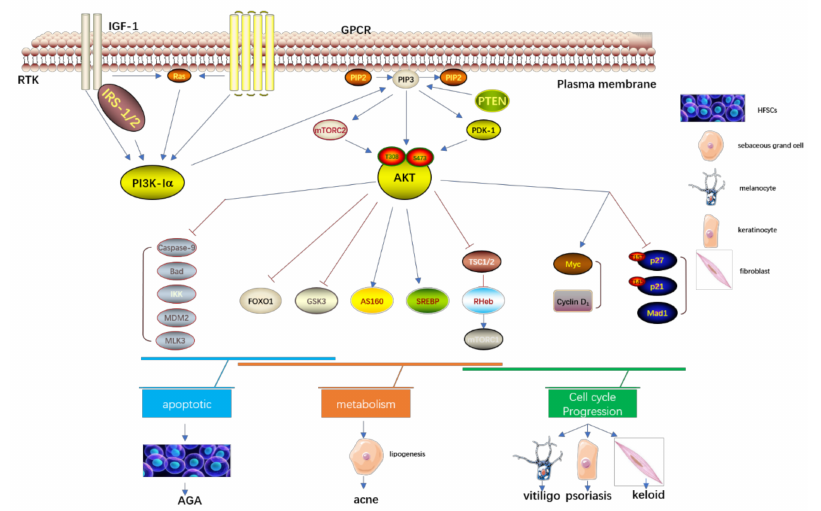
Figure 2. The PI3K/Akt signaling pathway and a group of non-malignant skin disorders; IGF-1, insulin-like growth factors-1; IRS-1/2,insulin receptor substrate-1/2; AKT, protein kinase B; IGF- 1, insulin-like growth factors-1; IRS-1/2,insulin receptor substrate-1/2; FoxO1, Forkhead box O1; GSK3, glycogen synthase kinase 3; GPCR, G-protein-coupled receptors; IRS-1/2,insulin receptor substrate-1/2; IKK, IkB-kinase; MAD1, MAX dimerization protein 1; MDM2, murine double minute 2; MLK3, mixed lineage kinase 3; mTORC1/2, mTOR complex 1/2; PDK1, phosphoinositide-dependent protein kinase 1; PI3K, phosphatidylinositol 3-kinase; PIP2, phosphatidylinositol 4,5-biphosphate; PIP3, phosphatidylinositol 3,4,5-triphosphate; PTEN, Phosphatase and tensin homologue; RTK, receptor tyrosine kinases; SREBP, sterol regulatory element-binding proteins; TSC1/2, tuberous sclerosis complex 1/2; AGA, Androgenic